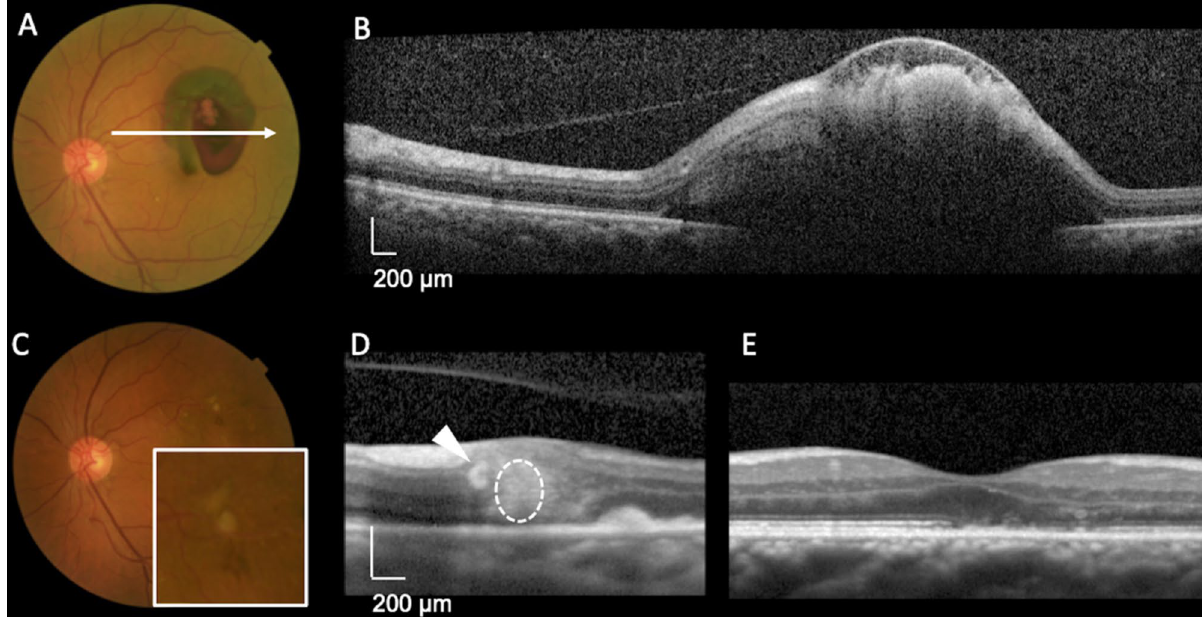
Figure 4. Representative case involving a 71-year-old man with a ruptured retinal arterial macroaneurysm at the same level as the affected artery (lateral type) in the left eye. At the initial visit, the visual acuity was 20/16. Optical coherence tomography (OCT) obtained in the acute phase shows sub-inner limiting membrane (ILM) hemorrhage and subretinal hemorrhage around the retinal arterial macroaneurysm (RMA) ( B ). The thickness of the foveal subretinal hemorrhage was 149 μm. At 5 days after onset, we treated RMA with direct photocoagulation and intravitreal injection of ranibizumab. A color fundus photograph ( C ) shows RMA protruding toward the center of the fovea without interfering with the course of the affected artery. OCT ( D ) shows RMA (dotted circle) located at approximately the same level as the artery (arrow). Thus, it was classified as the lateral type. At 24 months after onset, the length of the ellipsoid zone band defect at the fovea was 817 μm ( E ), and the visual acuity was